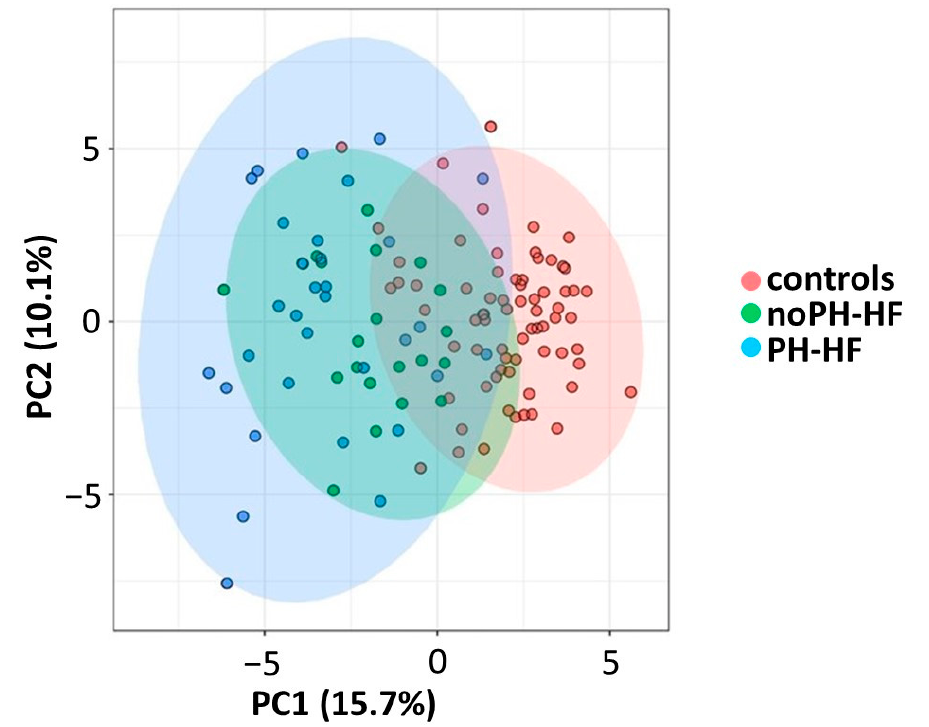
Figure 1. Principal component analysis identified distinct metabolic patterns in PH-HF ( n = 33) and noPH-HF ( n = 27) and segregated HF patients from healthy subjects ( n = 72). A total of 55 variables were included in the analysis and comprised usual biochemical parameters as well as various metabolites measured by a combination of MS-based metabolomics approach targeting fatty acids, acylcarnitines, organic acids and amino acids. For the segregation between healthy subjects (controls) and HF patients, principal component 1 (PC1) and principal component 2 (PC2) accounted for 15.7% and 10.1% of the total variation, respectively. Controls are identified in red, noPH-HF in green and PH-HF in blue. Biplot analysis merging PCA plot and loadings plot identified the most potent metabolites in segregating controls (red) and noPH-HF (green) with PC1 and PC2 accounting for 11.9% and 9.3% respectively, and controls (red) and PH-HF (blue) with PC1 and PC2 accounting for 16.8% and 11.9% respectively. The corresponding loading scores in PC1 and PC2 for both analyses are reported in Table S1.